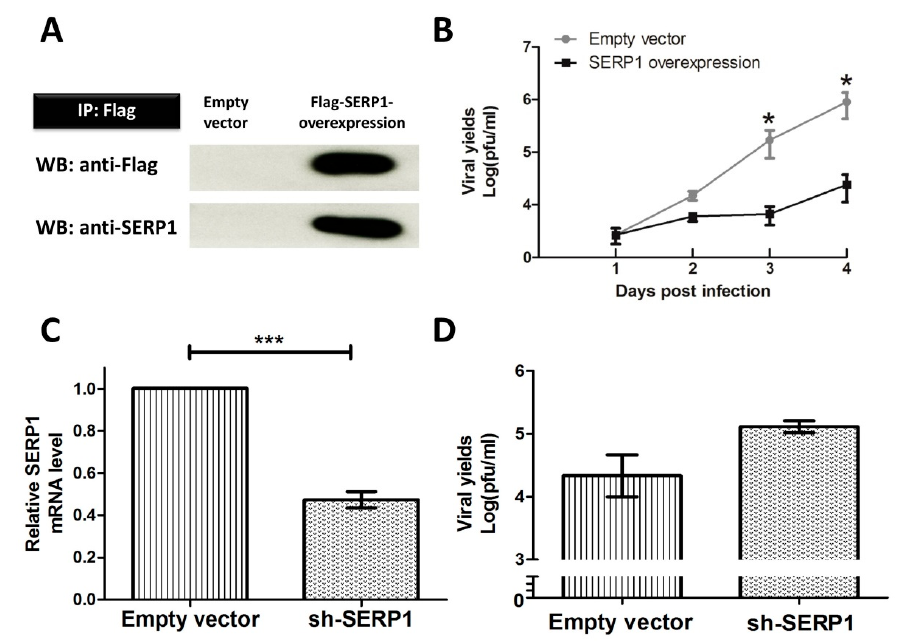
Figure 3. The SERP1 overexpression inhibited DENV-2 infection, and SERP1 knockdown increased DENV-2 infection. ( A ) Western blot analysis of Flag-tagged SERP1 proteins in Huh7.5 cells expressing